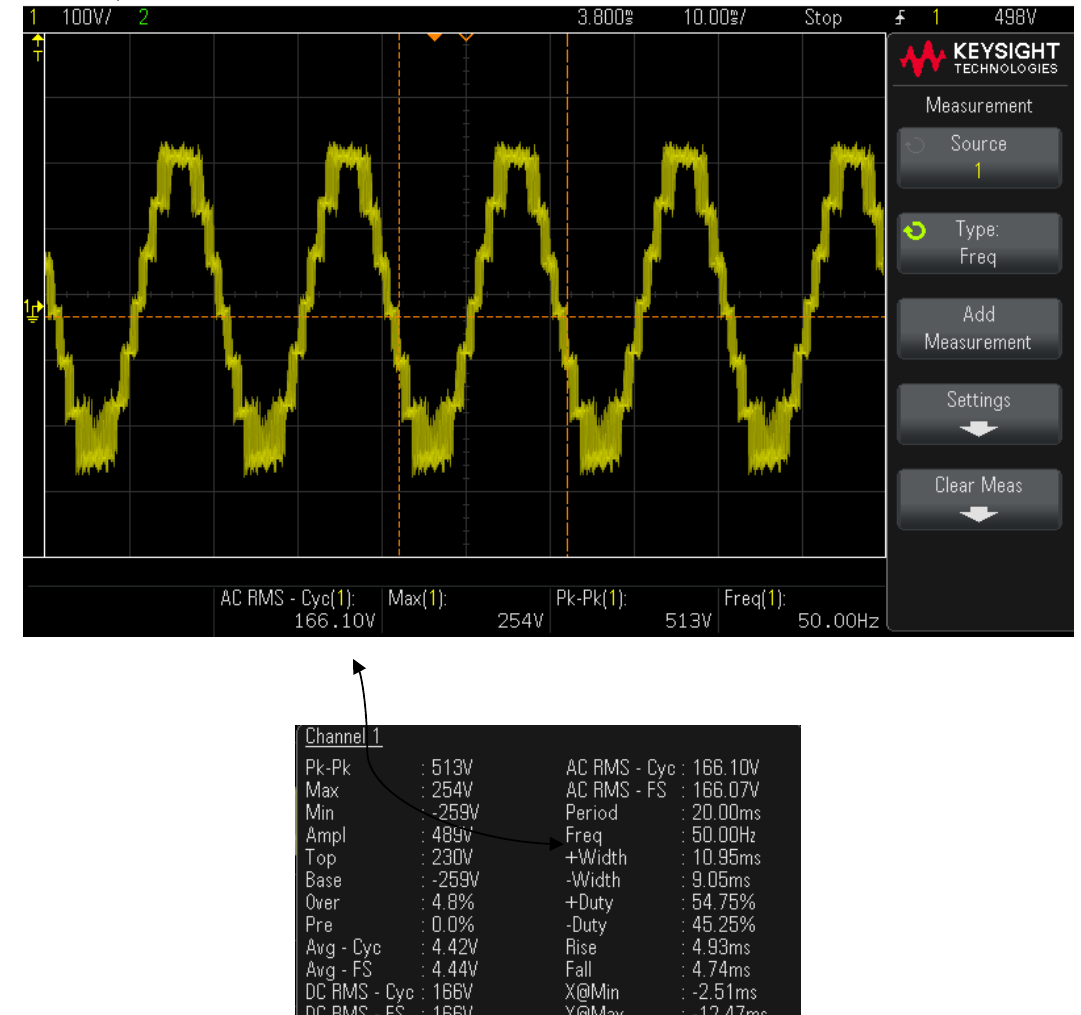
Figure 54. Output voltage waveform under closed loop condition.